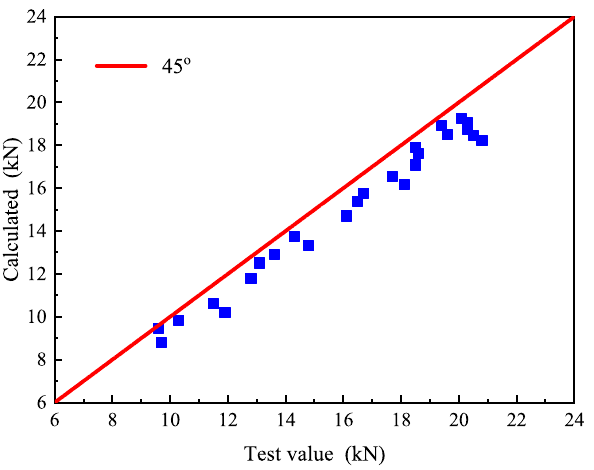
Figure 13. Comparison between model predictions and test